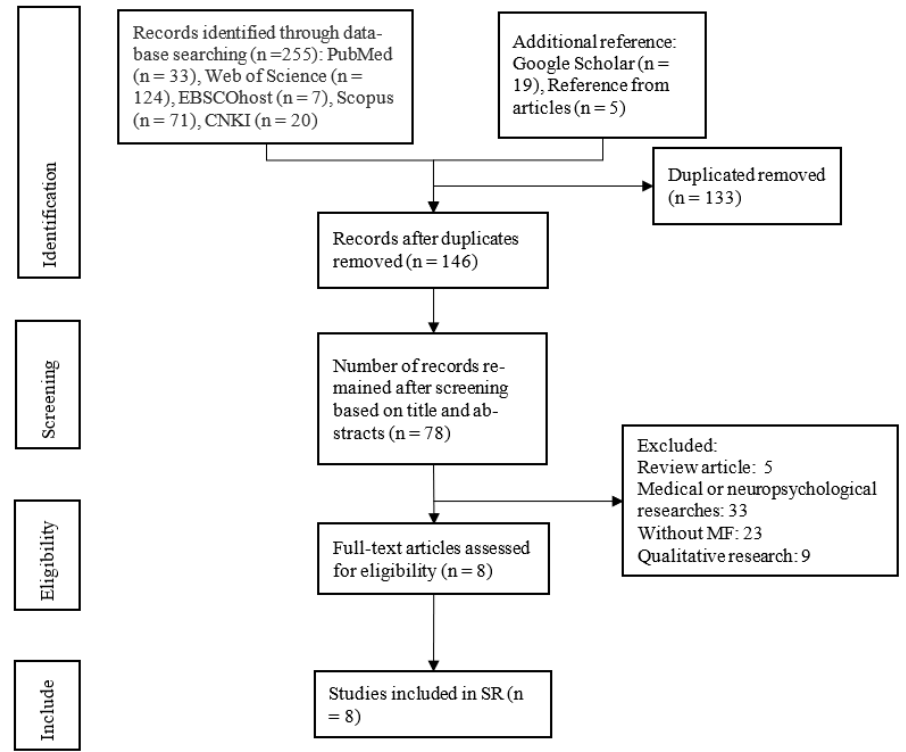
Figure 1. Systematic review search and screening procedure.